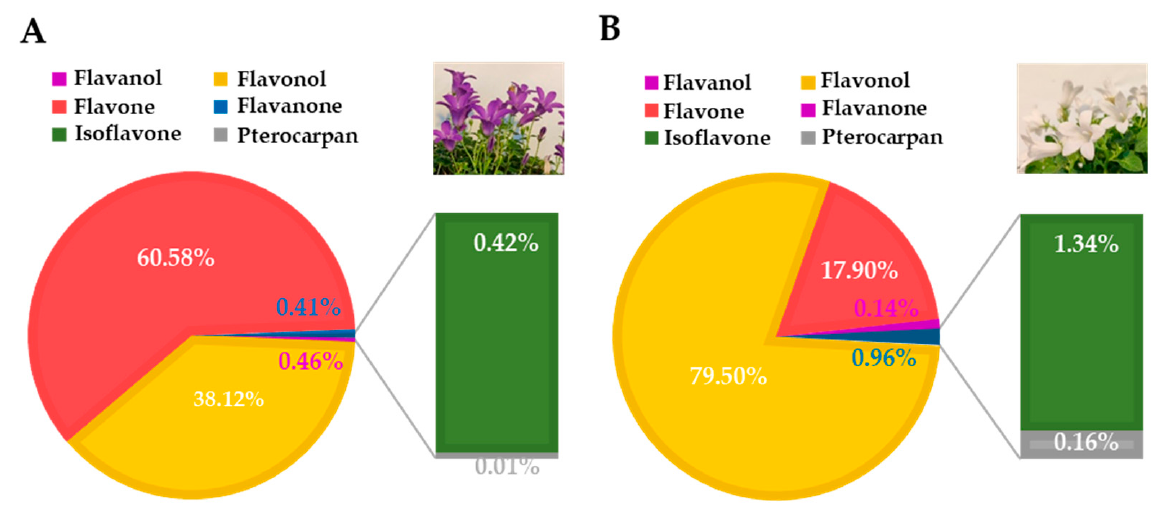
Figure 1. Flavonoid compounds accumulated in Deep Blue Ocean (DBO) and White Ocean (WhO) Campanula portenschlagiana genotypes. ( A ) Percentage of flavonoid groups in DBO petals. ( B ) Percentage of flavonoid groups in WhO petals.